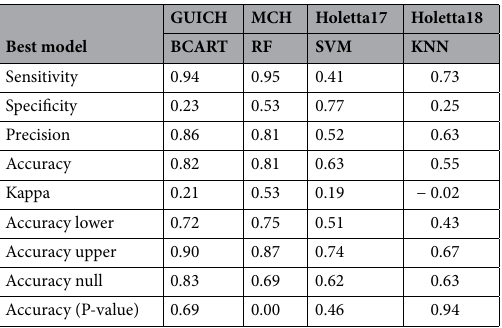
Table 4. Performance metrics for the best machine learning models for scald reaction of barley at adult plant stage in different environments. BCART Bagged Carts, RF Random forest, SVM support vector machine, KNN K-nearest neighbors, MCH Marchouch